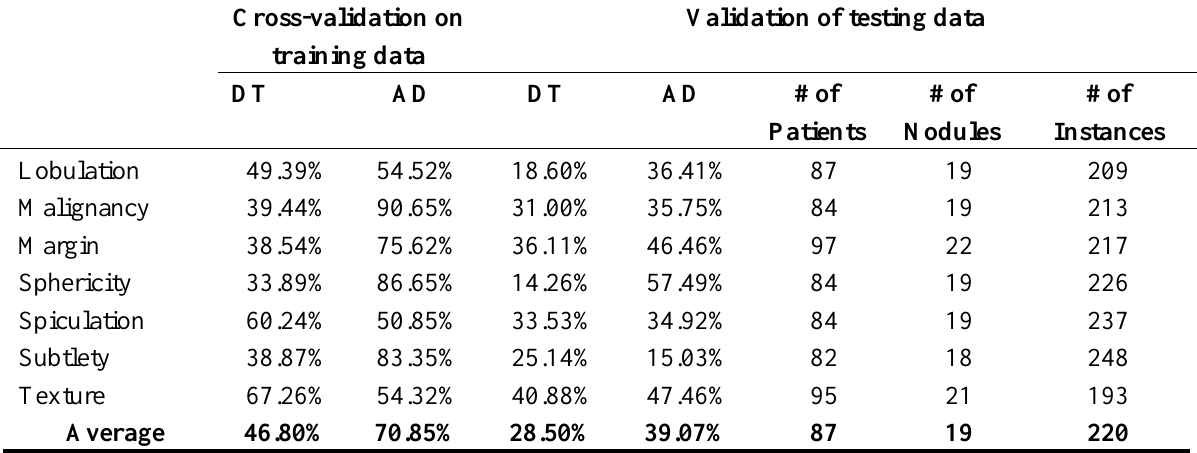
Table 8. Classification accuracies of Active-Decorate on original (90%) and reserved (10%)